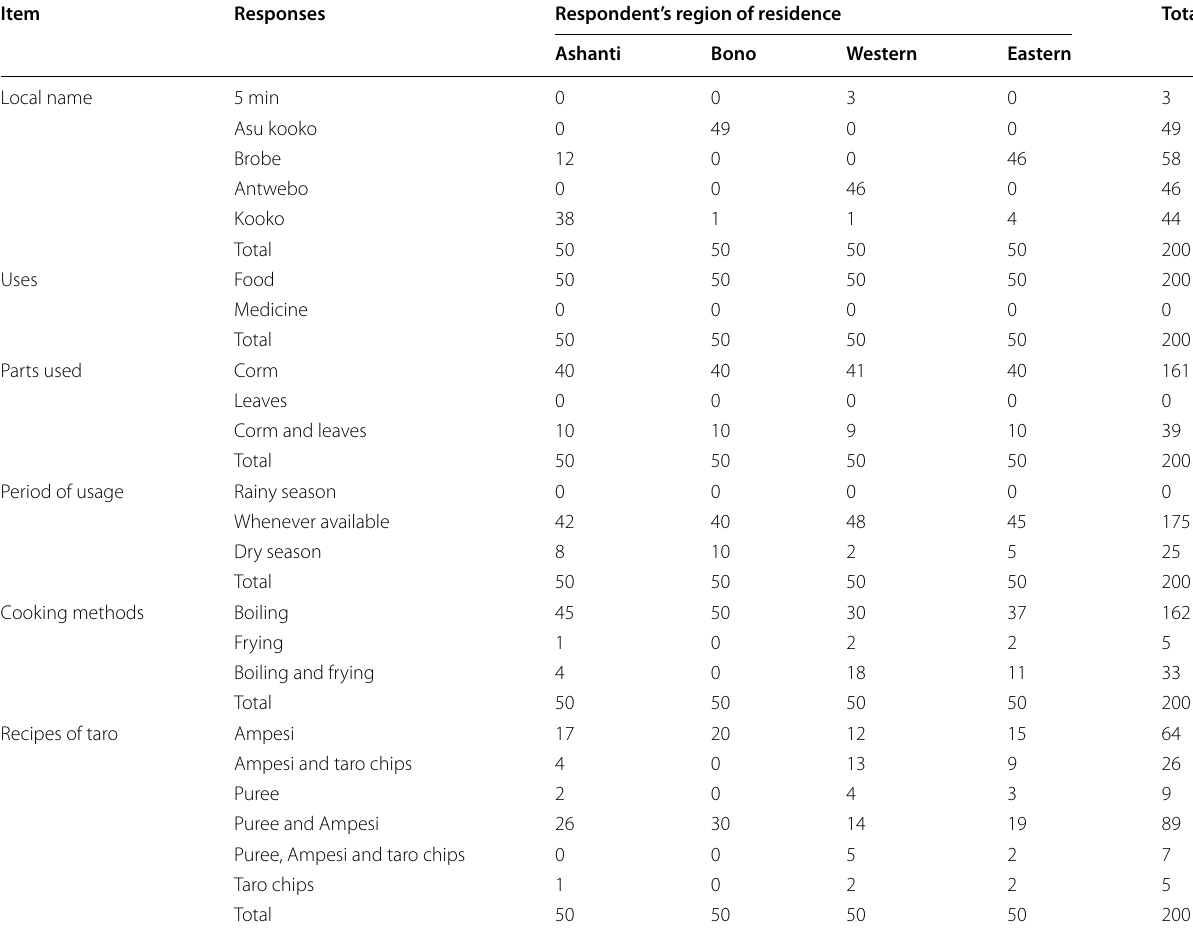
Table 2 Ethnobotany of taro in the study